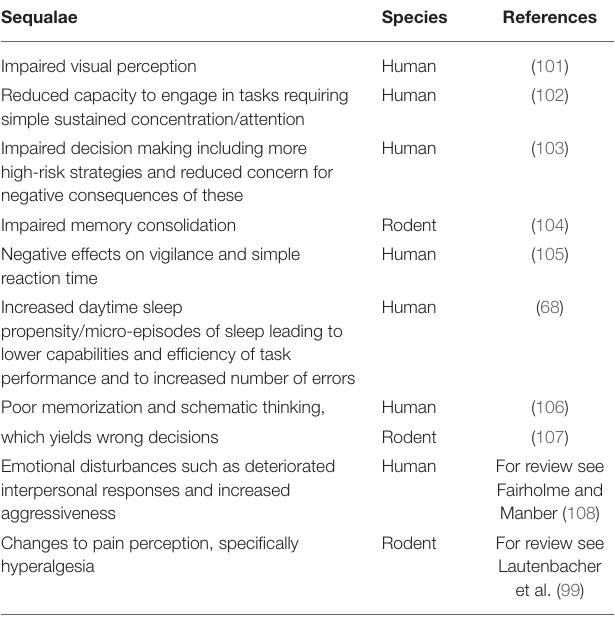
TABLE 5 | The after effects of sleep deprivation in human and rodent